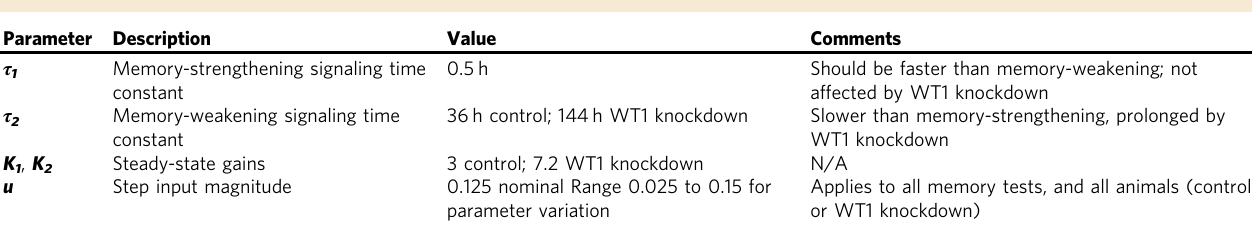
Fig. 7 Consequences of WT1 Δ -mediated impaired memory fl exibility. a Proposed mechanism of WT1 ’ s effect on memory regulation. An initial experience such as Task 1 (NOL) activates both pro-memory strengthening and pro-memory weakening pathways. When the memory weakening pathways are inhibited by depletion of WT1, there is prolonged memory for Task 1. Retention of Task 1 memory may or may not interfere with the ability to remember a Task 2 (CFC) based on the availability of effectors (limiting vs in excess). b Schematic representation for short-interval sequential training in mice (top panel). Wt1 Δ mice showed increased time spent exploring the new location when fi rst trained in NOL and tested 24 h after training (left panel, unpaired t test: * p = 0.0422. Dashed line indicates 50% preference). In the next day after being tested in NOL mice were trained on CFC and Wt1 Δ mice spent signi fi cantly less time freezing than Control littermates when tested 24 h after training (right panel, unpaired t test: * p = 0.0161). c Schematic representation for long-interval sequential training (top panel). Wt1 Δ mice showed increased time spent exploring the new location when fi rst trained in NOL and tested 24 h after training (left panel, unpaired t test: ** p = 0.0036. Dashed line indicates 50% preference). Nine days after being tested in NOL, Wt1 Δ mice were trained on CFC and compared with control group, they spent comparable amount of time freezing when tested 24 h after training (right panel, unpaired t test: p = 0.3816). Data are expressed as mean ±